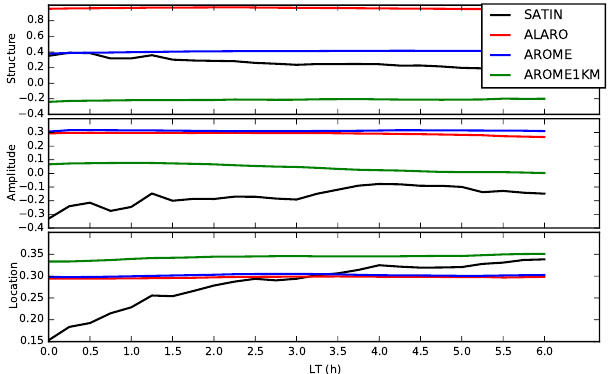
Figure 9. Comparison of pure (translational) nowcasting with NWP models: FBI, TSS, ETS versus lead time, averaged over five days with heavy precipitation.